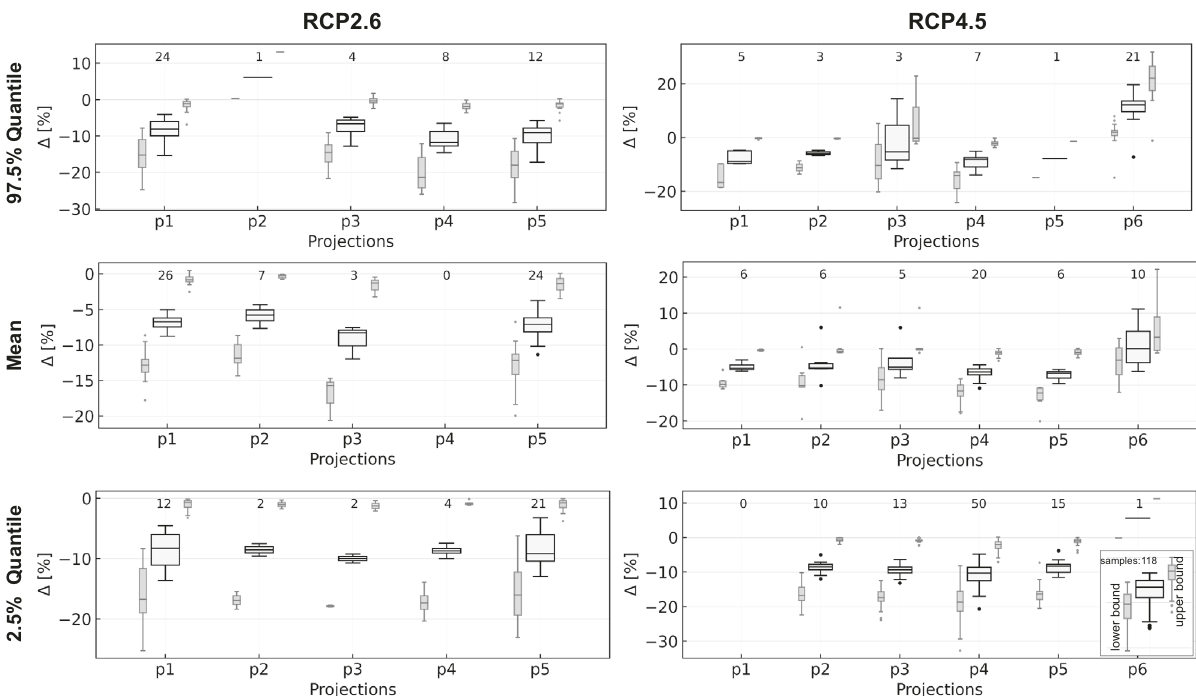
Fig. 2 Groundwater level changes (RCP2.6, RCP4.5). Boxplots showing the signi fi cant ( p < 0.05) relative changes between 2014 and 2100 based on linear trend analyses of annual quantiles (2.5% and 97.5%) and the annual mean under RCP2.6 (left) and RCP4.5 (right). Light gray/sideways boxplots show the uncertainty of the change as a 95% con fi dence interval. The numbers above boxplots depict the sample size (number of signi fi cant